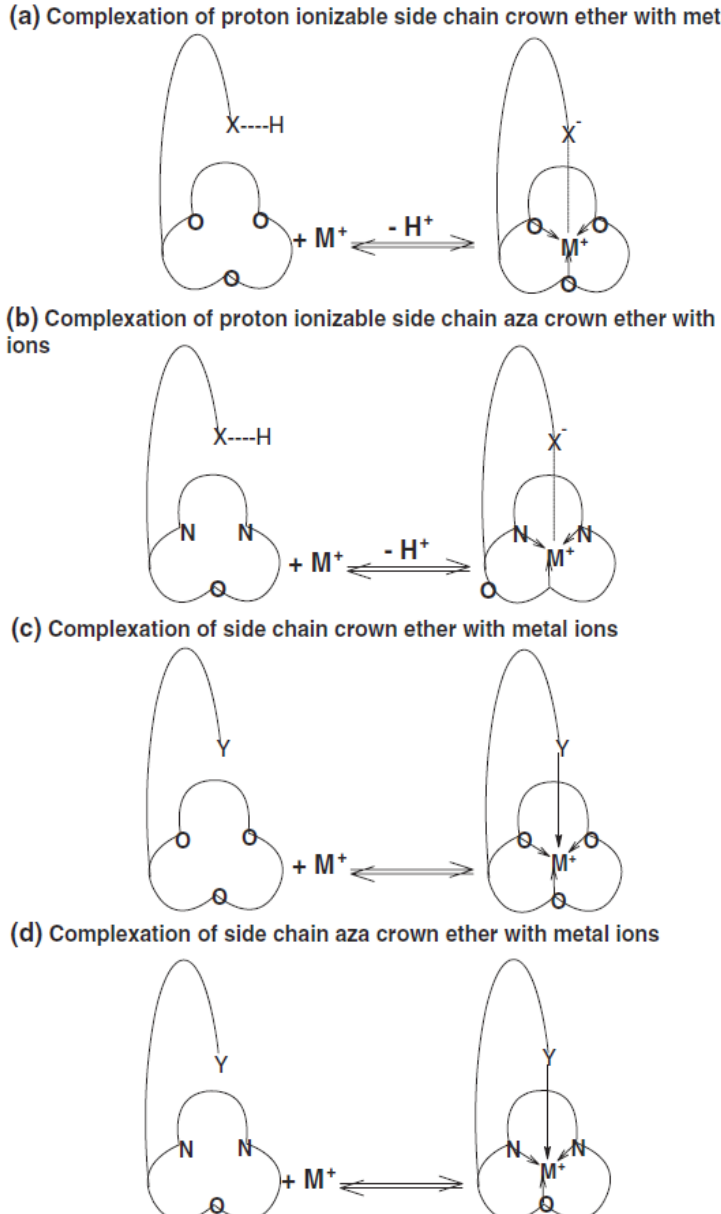
Figure 16. General mechanism of complexation of lithium by crown ether and aza crown ether with pendant side arms [181]. Reproduced with permission from Wiley. Swain, B. (2016), Separation and purification of lithium by solvent extraction and supported liquid membrane, analysis of their mechanism: a review. J. Chem. Technol. Biotechnol., 91: 2549–2562. https://doi.org/10.1002/jctb.4976.